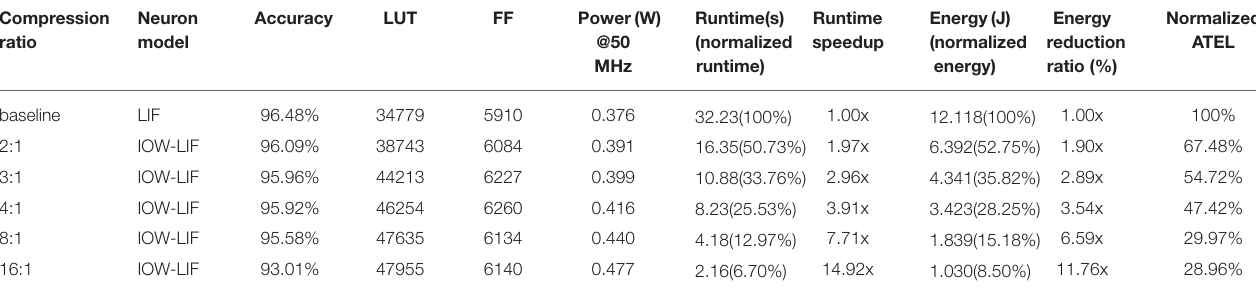
TABLE 4 | Comparison of the baseline and time compressed multi-layer feedforward SNN accelerators on the MNIST dataset. Compression ratio